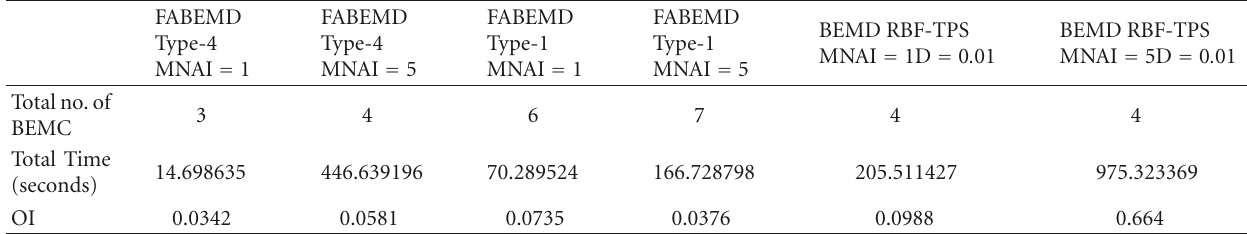
Table 2: Comparison among various FABEMD/BEMD for the STI in terms of total number of BEMCs, total time required, and orthogonality index